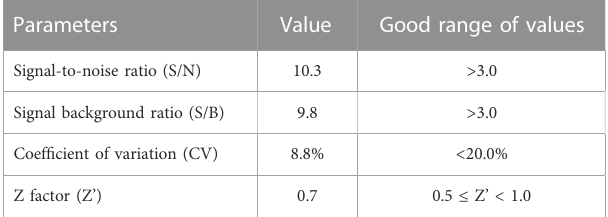
TABLE 2 The key evaluation parameters of in vitro high-throughput screening